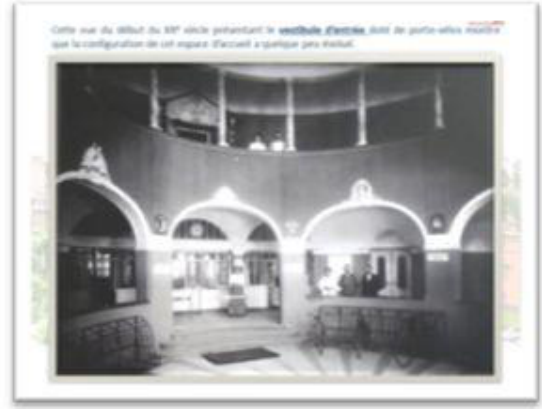
Figure 9: Image of archive integrated in the virtual tour.